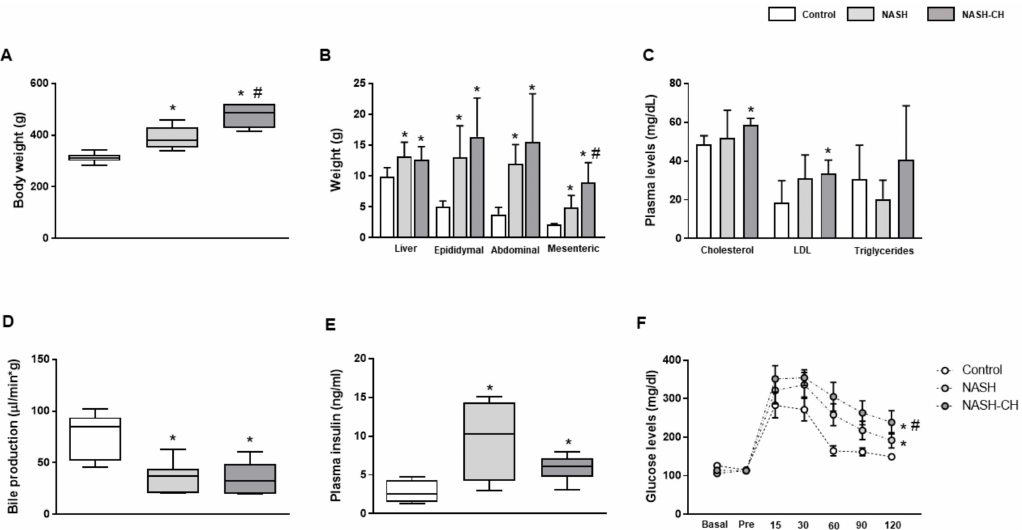
Figure 1. Metabolic profile of control and NASH rats. ( A ) Body weight, ( B ) liver weight, epididymal, abdominal, and mesenteric white adipose tissue weights, ( C ) plasma cholesterol, LDL, and triglycerides, ( D ) bile production, ( E ) plasma insulin levels, and ( F ) glucose tolerance tests were measured in control, NASH, and NASH-CH rats. Results represent mean ± SEM, * p < 0.05 vs. control group, # p < 0.05 vs. NASH group ( n = 6 rats per